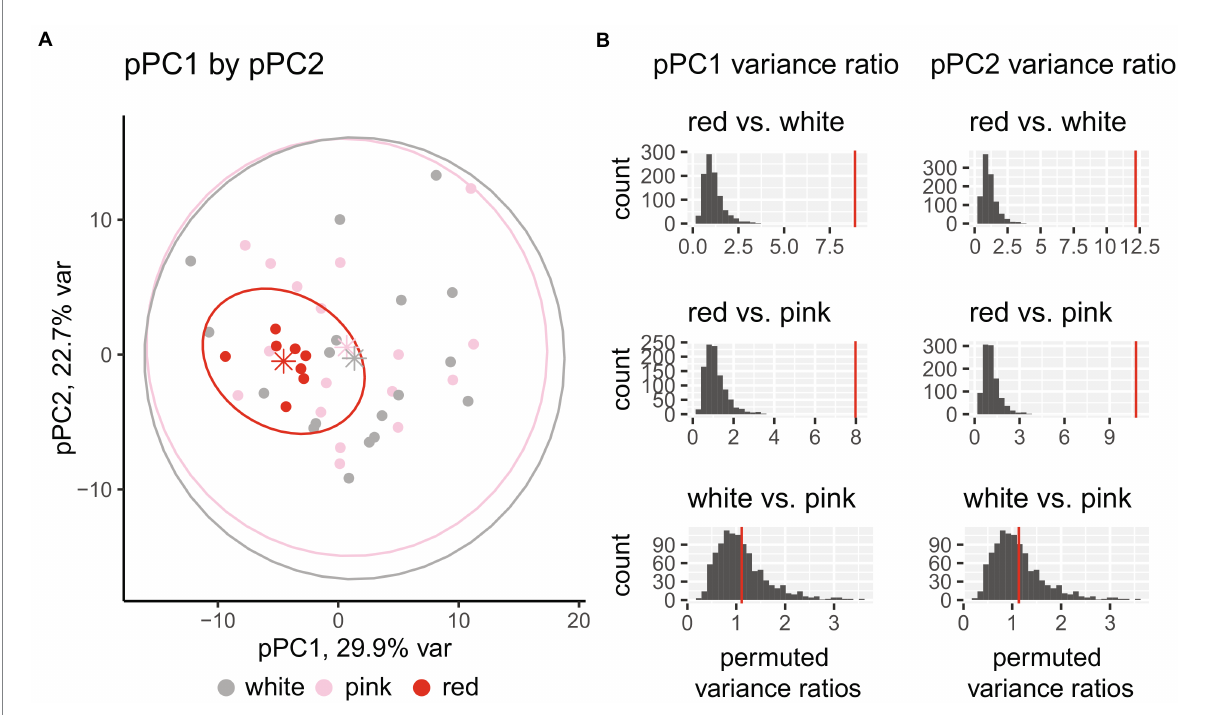
FIGURE 3 (A) Phylogenetic PCA (pPCA) of floral morphological trait variation. Each species with a corresponding ITS sequence ( N = 43) is represented by a single dot, with the color indicating the floral color. Floral color points are bounded by ellipses representing 95% confidence intervals. Mean pPC values for each floral color group are represented as stars. (B) Ratio of variances between each flower color for both pPC1 and pPC2 with empirical values as red vertical lines and distribution of 1,000 randomized permutations shown in gray bars. Permutation tests demonstrate that red-flowering species have much lower morphological variance compared to both pink- and white-flowering species ( p < 0.05, one-sided permutation test of the ratio of variances). The difference in variance between white- and pink-flowering species is not statistically